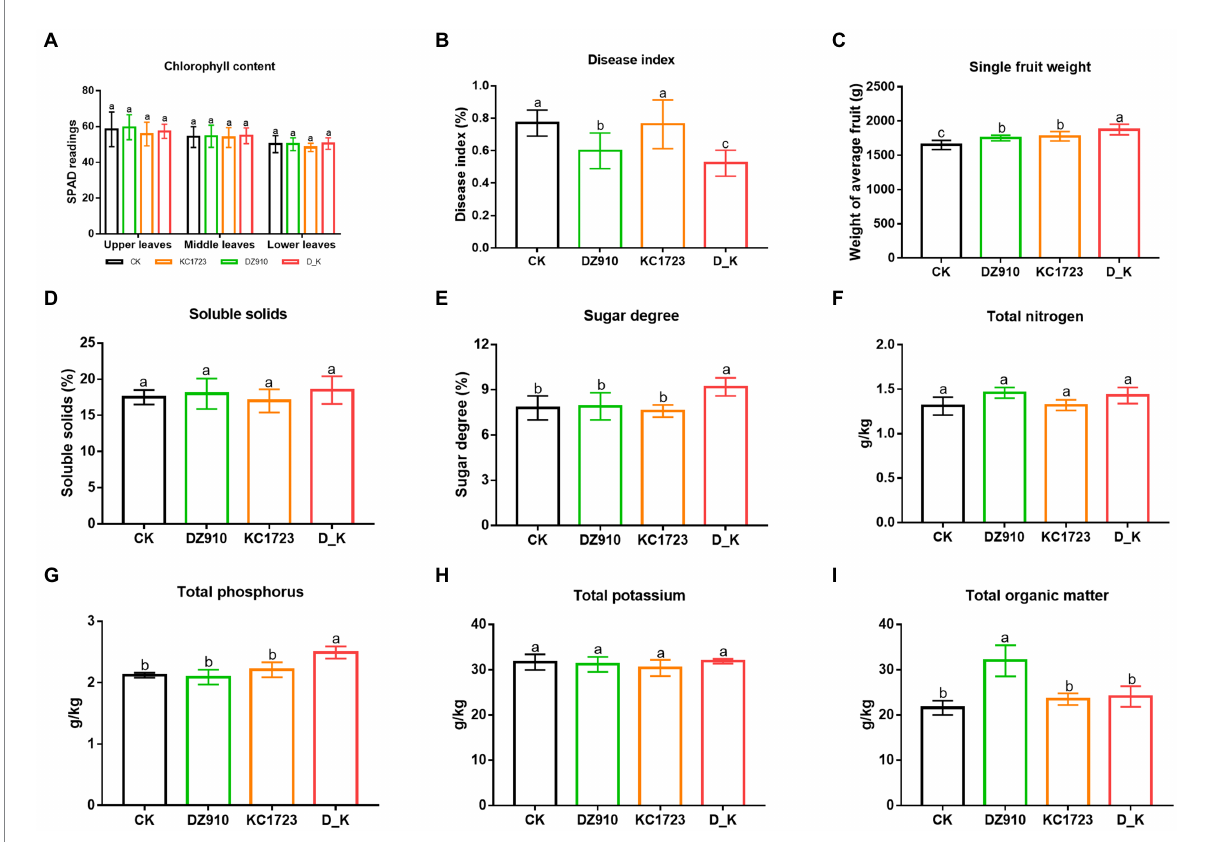
FIGURE 1 Changes of watermelon performance and soil physicochemical properties in different treatments. (A) chlorophyll content, (B) disease index, (C) SWF, (D) soluble solids, (E) sugar degree, (F) total nitrogen, (G) total phosphorus, (H) total potassium, and (I) total organic matter. The letters above the values indicate significant differences in different treatments (analysis of variance [ANOVA]: Duncan test; p <